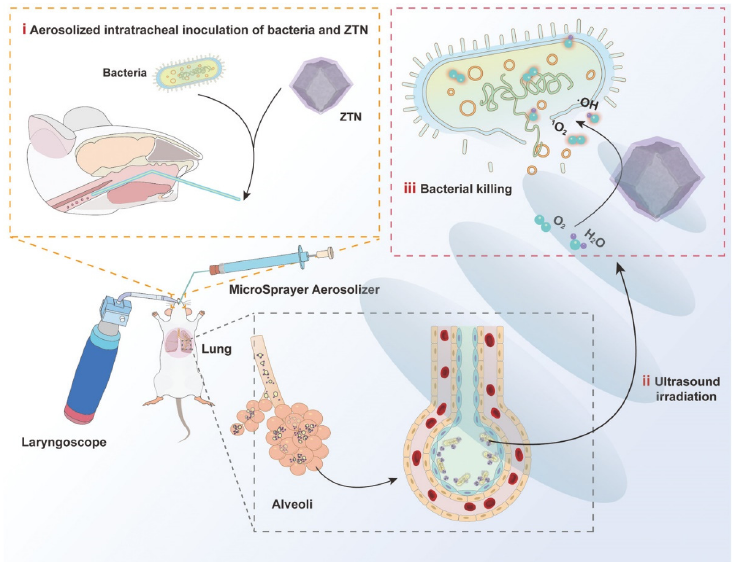
Figure 14. Schematic illustration of ZTNs for SDT of bacterial lung infections. Modified and repro- duced with permission from the Wiley-VCH GmbH [148].